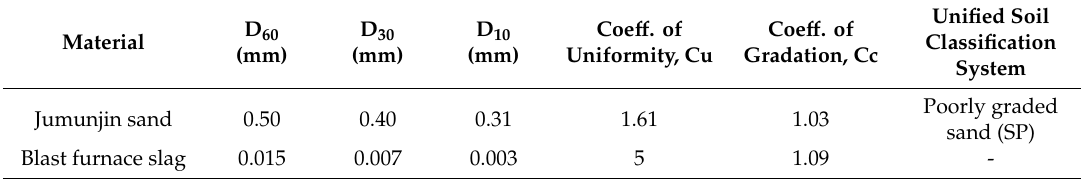
Figure 2. Particle shape of the used materials. (a) Particle shape of Jumunjin sand , ( b ) Particle shape of blast furnace slag. Table 1. Physical properties of Jumunjin sand and BFS.